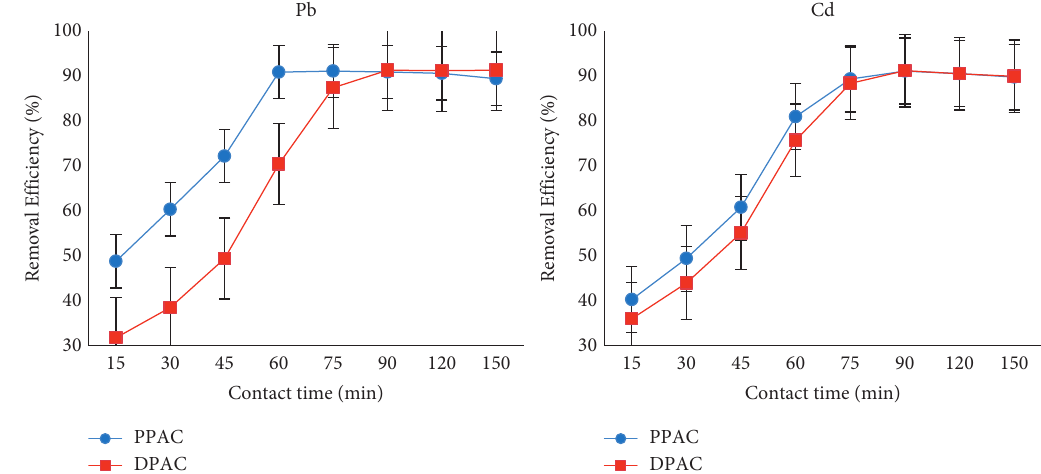
Figure 7: Effect of contact time on the adsorption of Pb(II) and Cd(II) onto the surfaces of DPAC and PPAC (pH � 6, metal concen- tration � 100mg/L, DPAC dose � 1g/L, and PPAC dose � 0.5g/L).